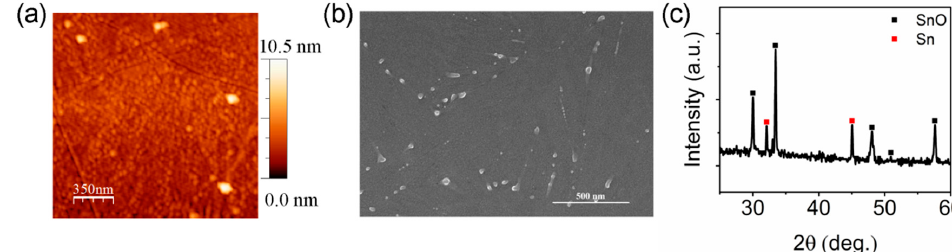
Figure 2. ( a ) AFM surface morphology, ( b ) SEM image, and ( c ) XRD pattern of the SnO film after being annealed in air at 225 °C for 1 h.